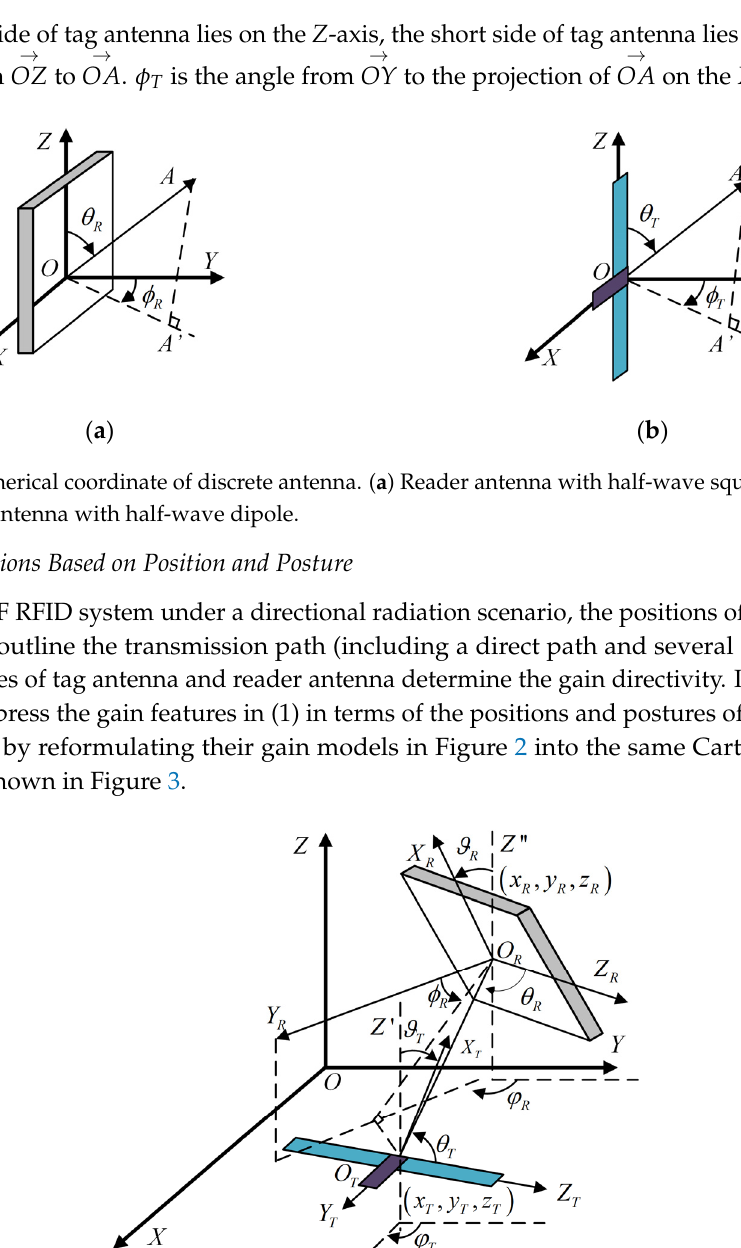
Figure 3. The Cartesian coordinate system for characterization of tag antenna and reader antenna.